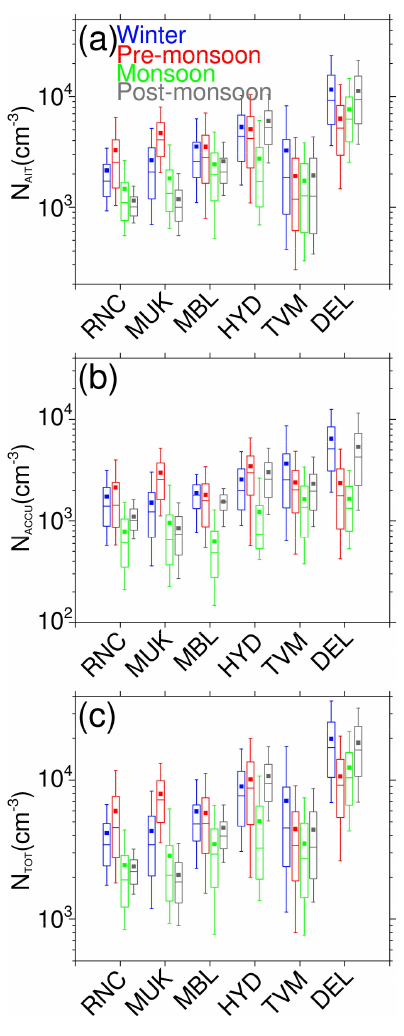
Figure 5. Box–whisker plot of seasonal number concentrations of (a) Aitken mode, (b) accumulation mode, and (c) total particles us- ing the entire data. The blue, red, green, and gray colors indicate winter (DJF), pre-monsoon (MAM), monsoon (JJAS), and post- monsoon (ON) months. The solid square indicates the mean, hor- izontal line indicates the median, the top and bottom of the box indicate 25th and 75th percentile values, and the top and bottom whiskers indicate 10th and 90th percentile values. Note that mea- surements are from different time periods for each site (see Table 1).